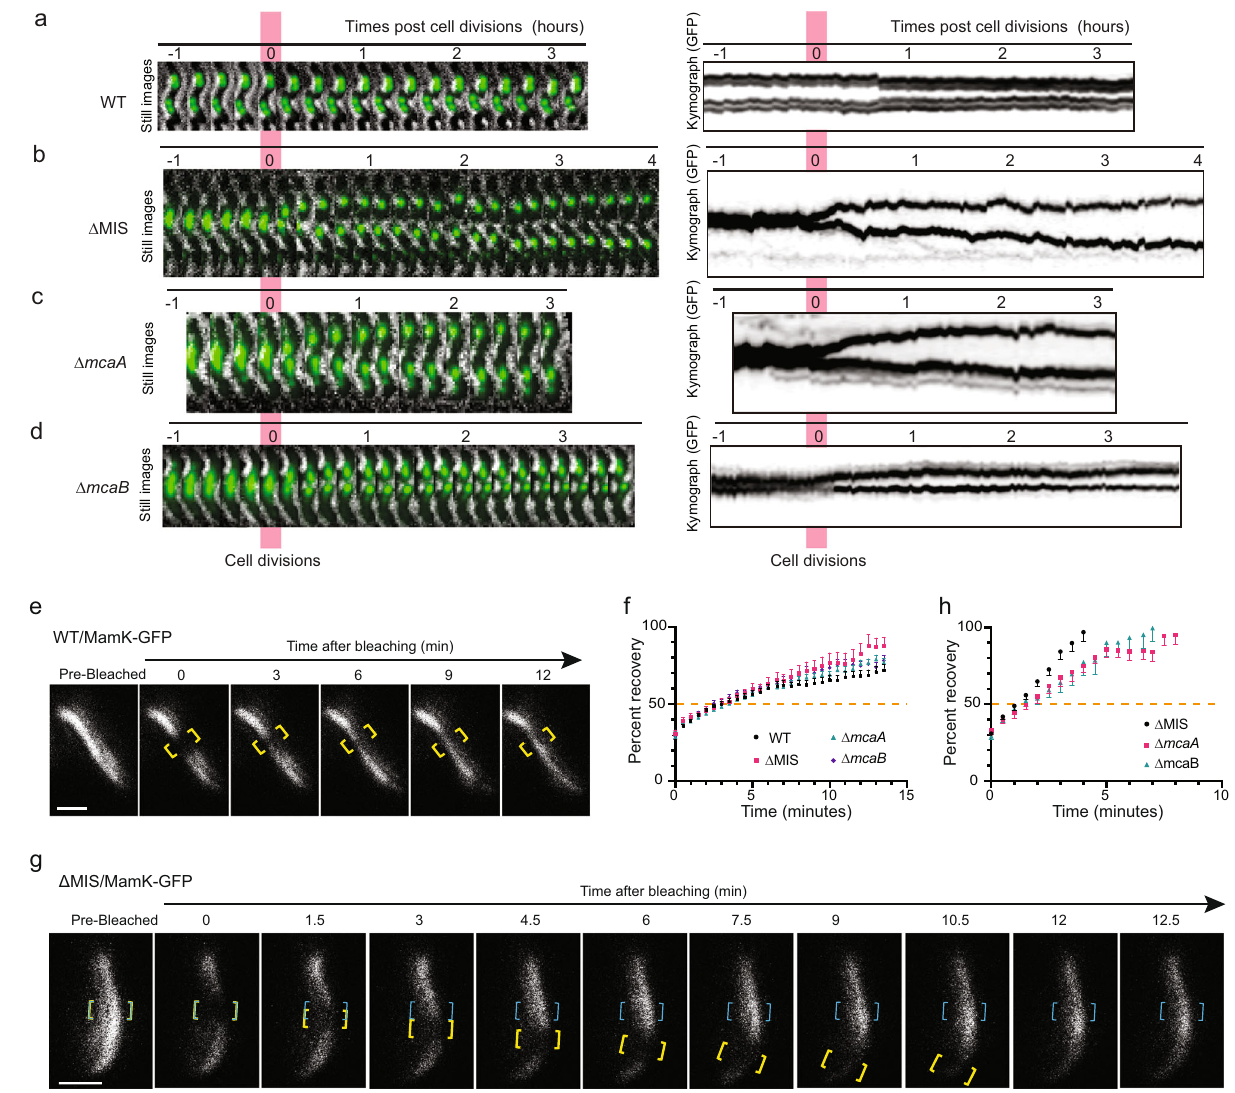
Fig. 8 | Live-cell imaging shows the behavior of magnetosome chains and dynamics of MamK fi laments. a – d Effects of mcaA and mcaB deletions on mag- netosome segregation. Live-cell time-lapse imaging of magnetosome segregation in WT ( a ), Δ MIS ( b ), Δ mcaA ( c ), and Δ mcaB ( d ) cells during cell division. Magne- tosomes were labeled with Mms6-GFP. Left: GFP fl uorescence and bright- fi eld merged time-lapse still images. Right: kymographs of Mms6-GFP signals in max- imum projection. e A FRAP experiment time course with a WT AMB-1 cell expres- sing MamK-GFP. Yellow brackets indicate the portion of the MamK-GFP fi lament designatedforphotobleaching. g AFRAPexperimenttimecoursewithan Δ MIScell expressing MamK-GFP where the bleached area moved from its original position